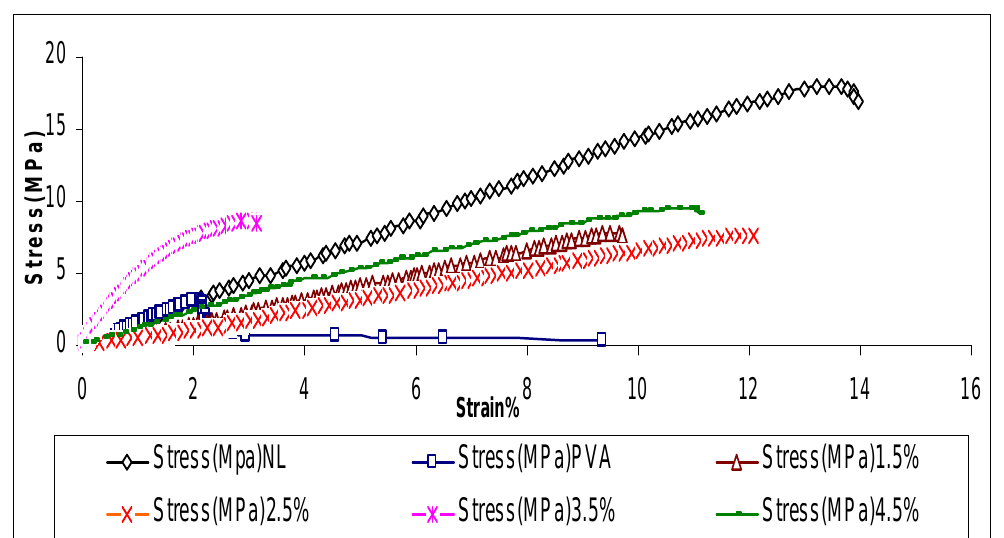
Fig. 5: Stress-strain curves of natural leather